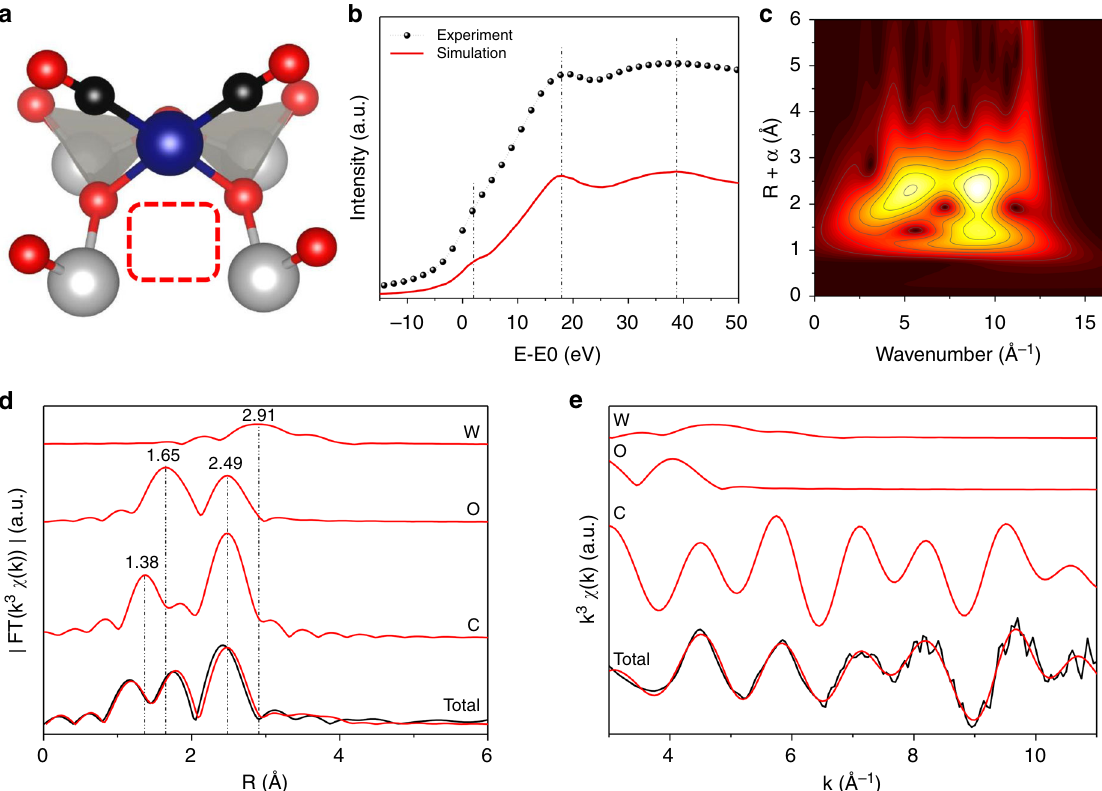
Fig. 2 Spectroscopic evidence for the formation of an oxygen vacancy. a DFT-optimized structure of the catalyst with oxygen vacancy and two bound CO molecules. Atom colors: W (gray), O (red), C (black), Rh (blue). b best fi t for the XANES simulation of the catalyst structure depicted in a ; c Morlet wavelet transform of the catalyst after treatment under CO. d , e EXAFS analysis of structure ( a ) in d R and e k space. Curves from bottom to top are the experimental scattering contributions (black) superimposed with the total fi tted scattering contributions, Rh – C, Rh – O, and Rh – W scatterings (all in vacancy (indicated by the dashed circle). The subsequent